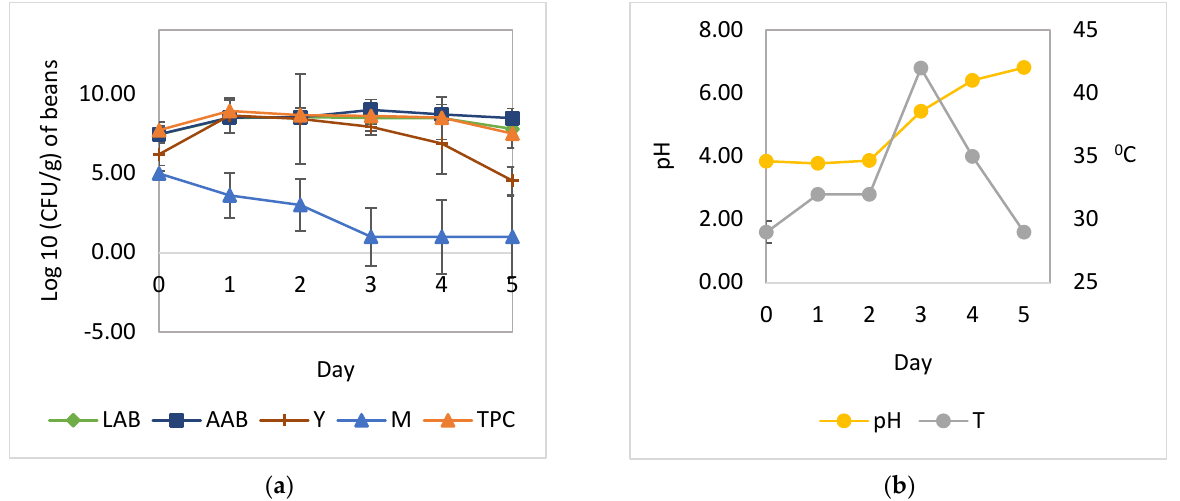
Figure 2. Microbial growth patterns and changes in pH and temperature during cocoa bean fermentation with the addition of L. plantarum HL-15 and A. niger YAC-9: ( a ) growth of yeast, LAB, AAB, and mold during fermentation; ( b ) temperature and pH. LAB, total lactic acid bacteria; AAB, total acetic acid bacteria; Y, total yeast; M, total mold; TPC, total plate count; pH, pH pulp; T, temperature.